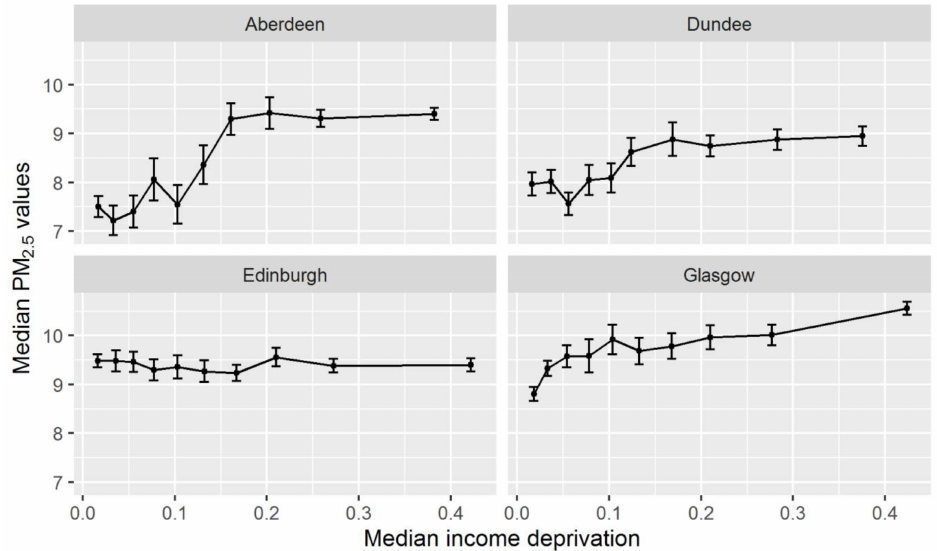
Figure 2. Pollution–deprivation relationship for four city-regions in 2004. Note: Deprivation deciles and associated median scores are defined at the national scale to facilitate comparison. These charts are plotted for 2004. Plots for 2006, 2009 and 2012 are also available as Supplementary Materials, available on request. Note: Median Income Deprivation is the median of scores in each